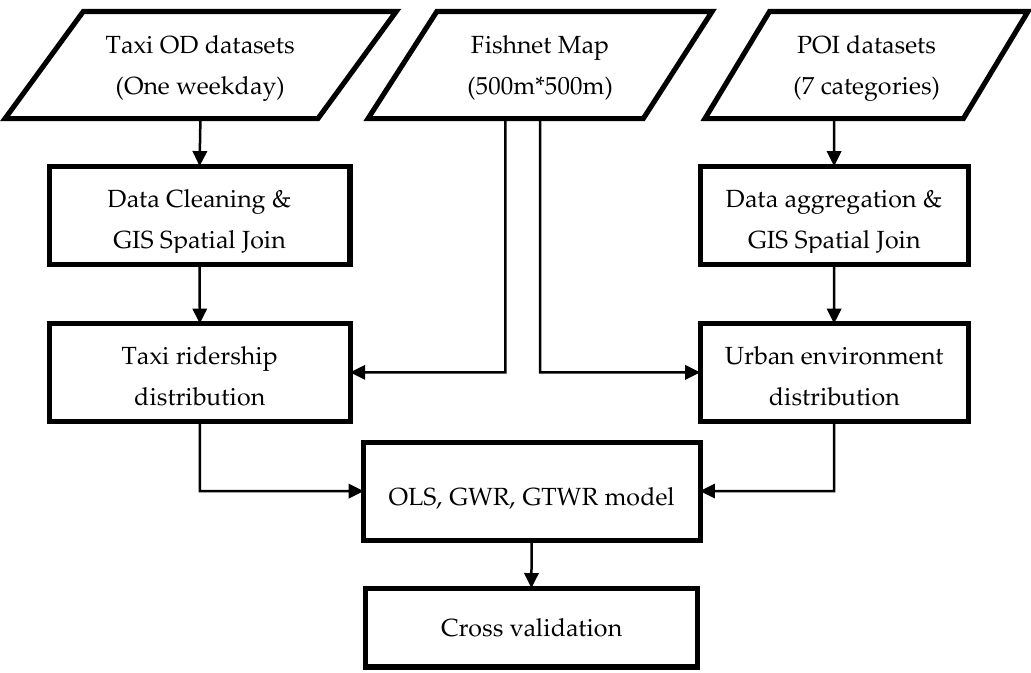
Figure 1. Flowchart of the proposed method for estimating hourly taxi trips on a 500 × 500 m 2 grid unit.